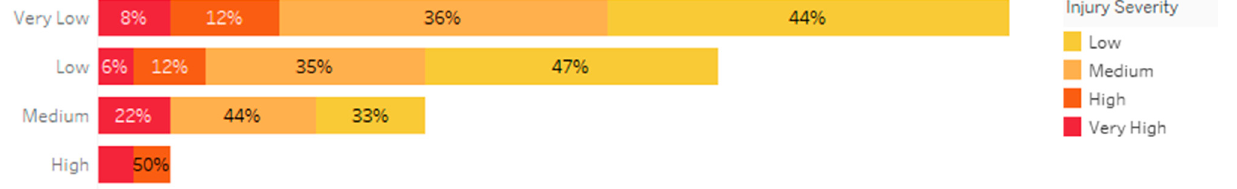
0 Figure 6. Percentage of injuries by incident classification. 3.3. Relationship between Severity and Injury Location Table 5 and Figure 7 below both show the number of injuries to each body part. For our sample company, back and hand injuries are both more numerous and more severe than other injuries. Figure 7 also adds data from Table 7 on the rate of recordable injuries for any given body part, allowing us to compare the frequency and severity of injury to specific body parts with the likelihood of those injuries being classified as recordable. Table 5. Injury severity and location. Insurance Claim Severity Injury Location